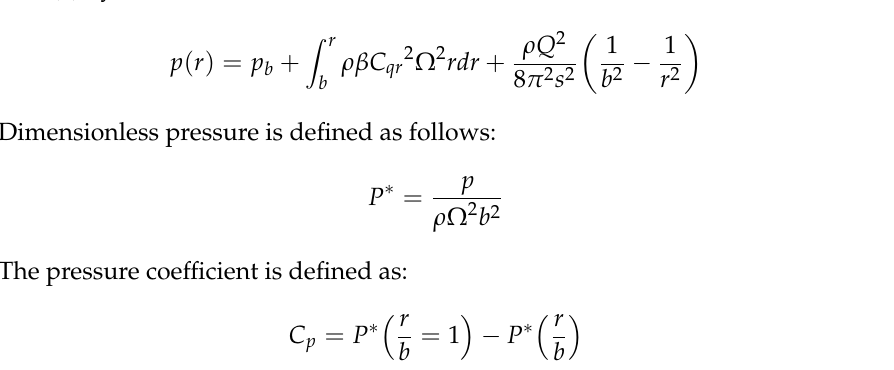
Figure 17. Distribution of mass flow rate for 𝐶 𝑤 = 10,137 , 𝑅𝑒 𝜑 = 5.12 × 10 5 , 𝐸 = 0.4 at r / b = 1.